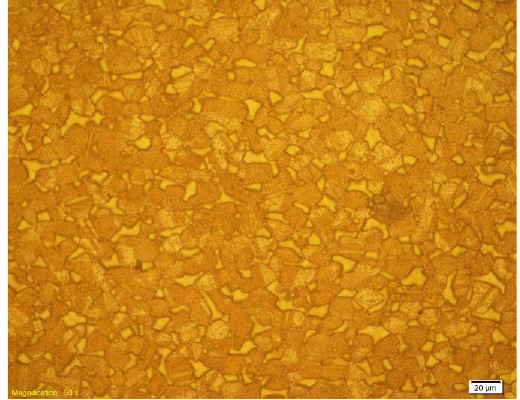
Figure 3. Bronze microstructure of CuAl9Fe3 (×500). A metallographic analysis of the electrospark coatings of the CuAl9Fe3 (CuAl8Fe3) and SPS bronze electrodes showed that the coatings had a dense structure with slight faults in the form of shells (1) and microcracks (2) (Figures 4 and 5).